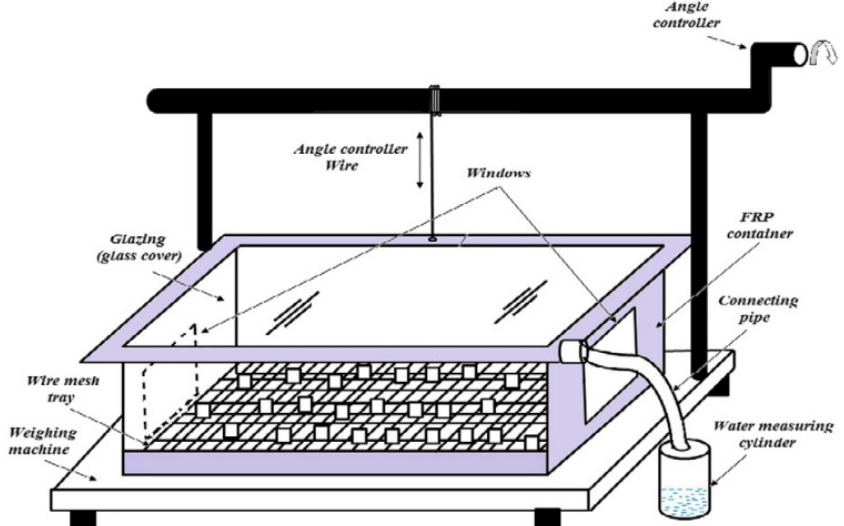
Figure 6. Flat dew collector and overturned pyramid collector.(Adapted with permission from Reference [35], Copyright 2015, Elsevier).